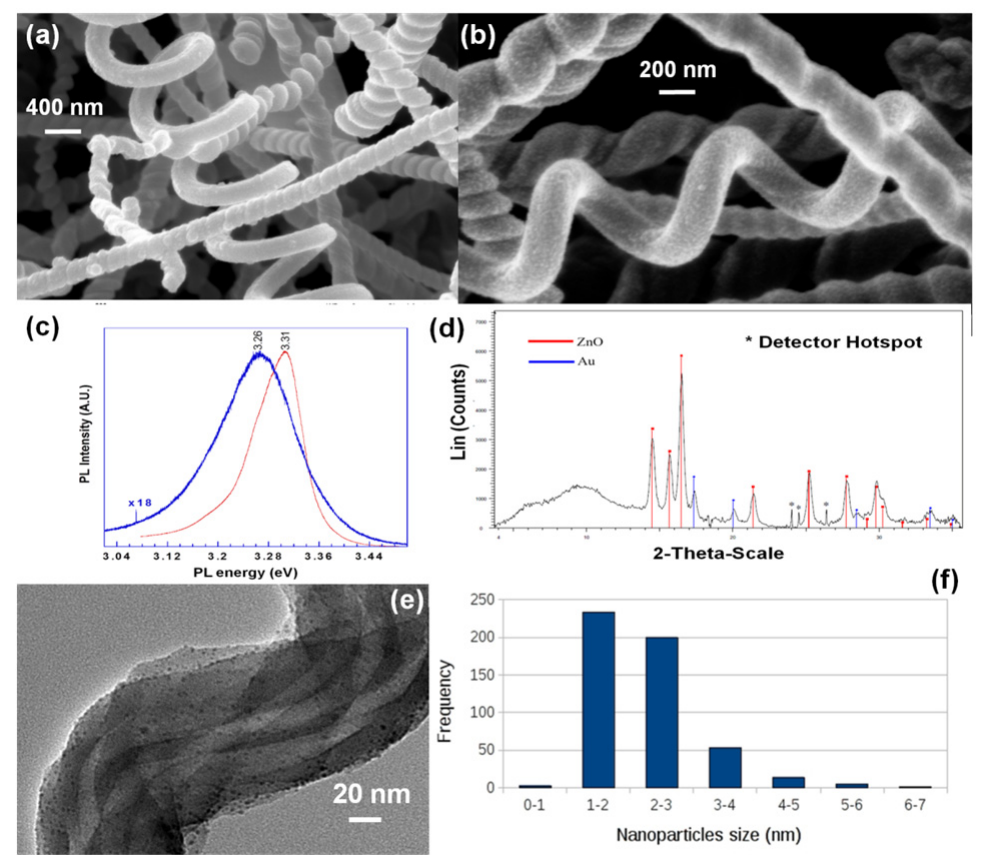
Figure 1. ( a,b ) SEM images of various ZnO coated nanosprings. ( c ) Room temperature photoluminescence spectra ZnO coated silica nanosprings (blue) and a single-crystal ZnO reference (red). ( d ) 2  -XRD rocking curve for ZnO coated nanosprings. ( e ) A TEM images of silica nanosprings, sans ZnO, coated with Pd nanoparticles. ( f ) The Pd nanoparticle